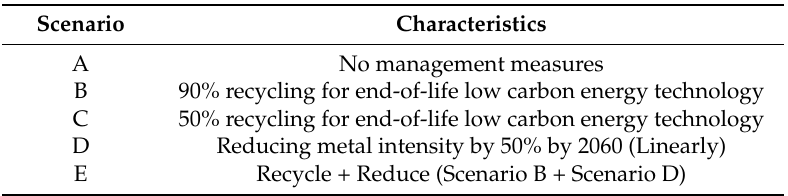
Table 8. Recycling and Reducing